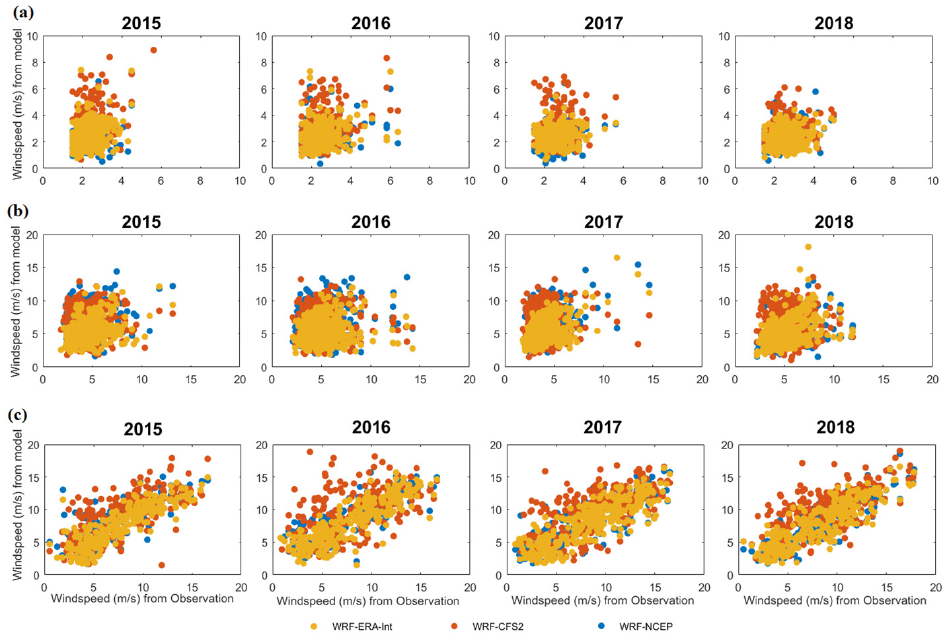
Figure 3. Daily average wind speed in m s − 1 from the models and observations at the locations ( a ) Nanping, ( b ) Hong Kong, and ( c ) offshore Quanzhou.